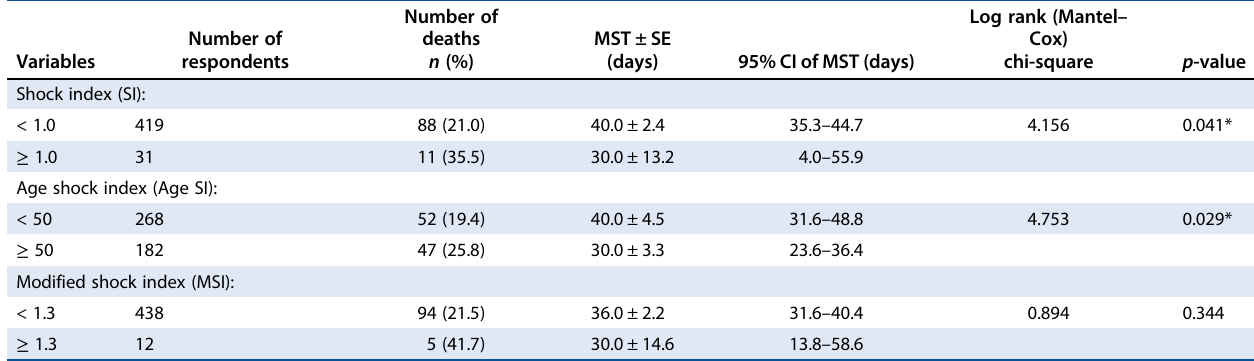
Table 3: Median survival times of hospitalisation by SI, MSI and age SI on admission